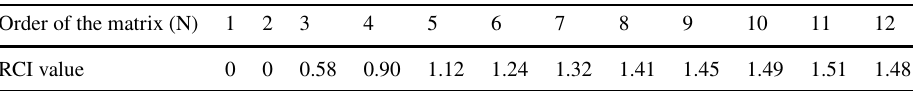
Table 7 Saaty’s consistency indices of randomly generated reciprocal matrices